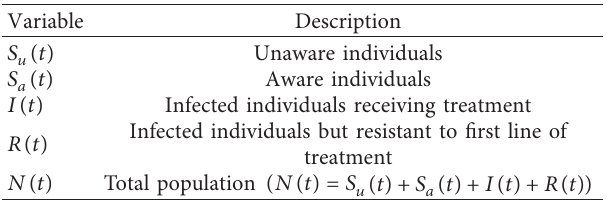
Table 2: Description of state variables.